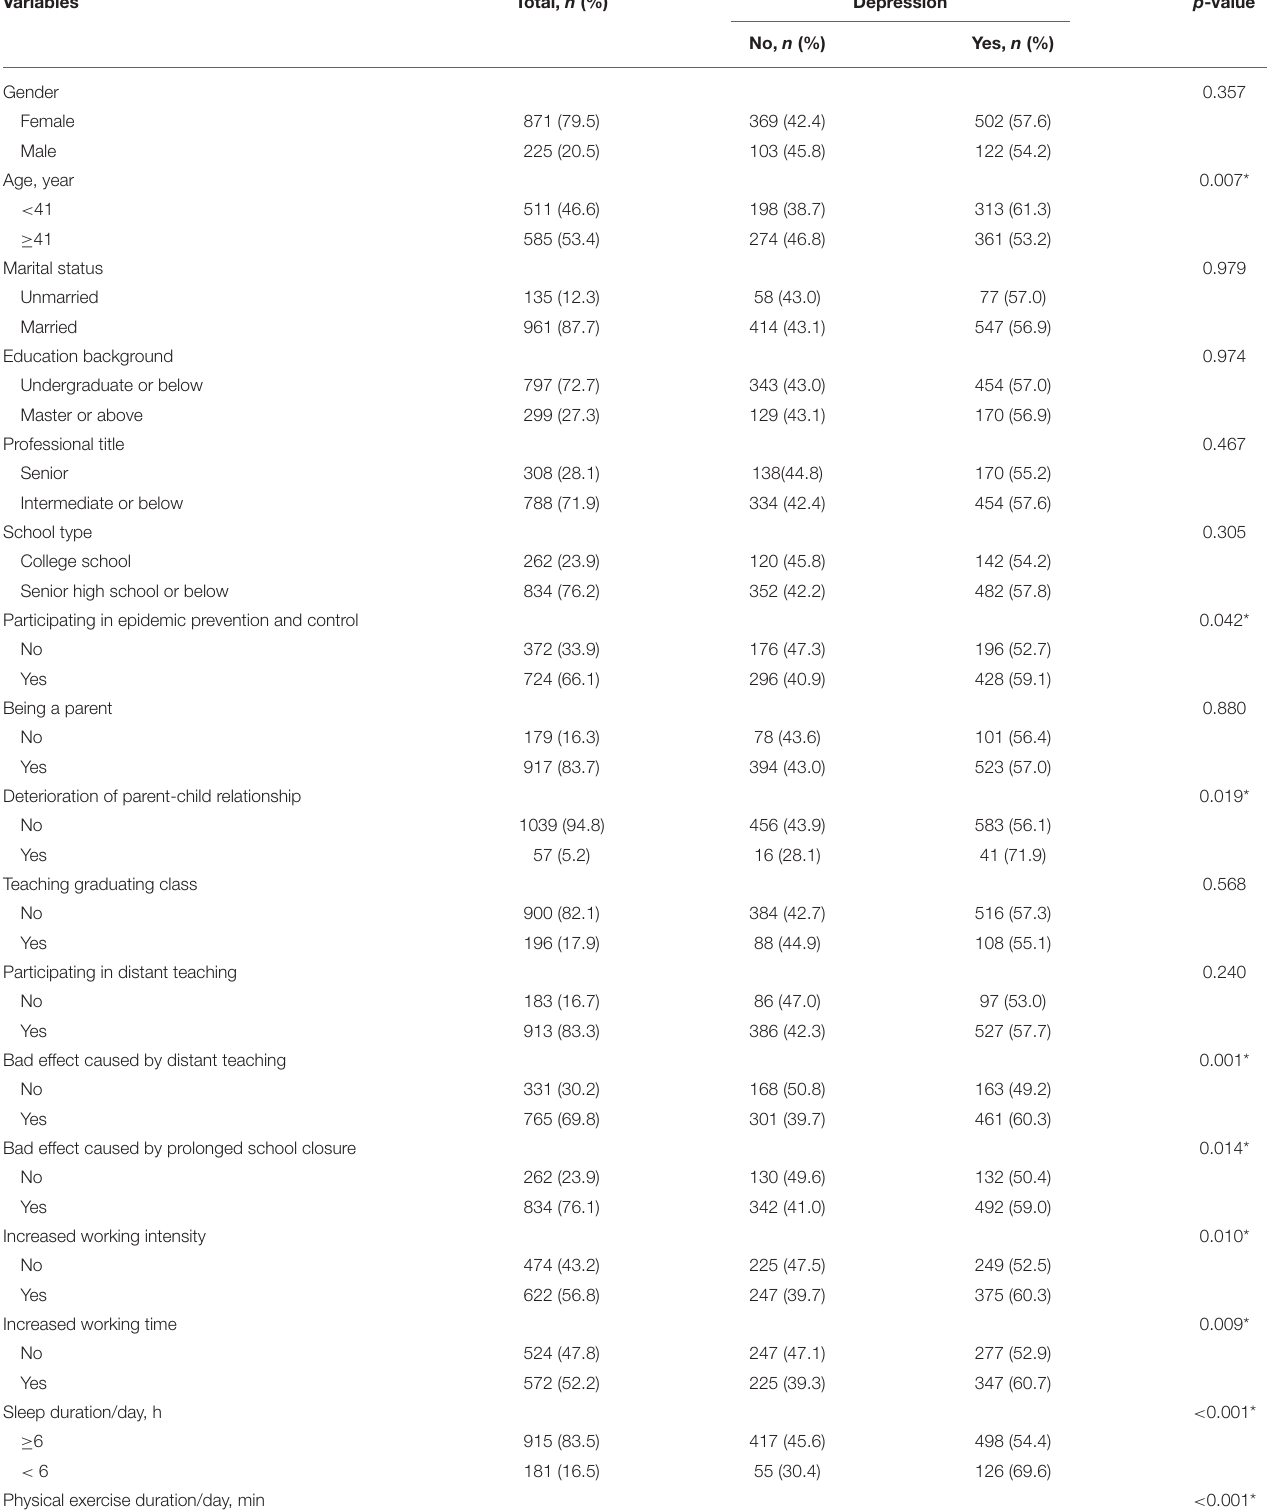
TABLE 1 | Demographic characteristics of the study sample ( n =